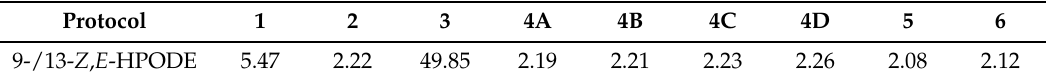
Table 2. 9- and 13-HPODE ratio in tested protocols.